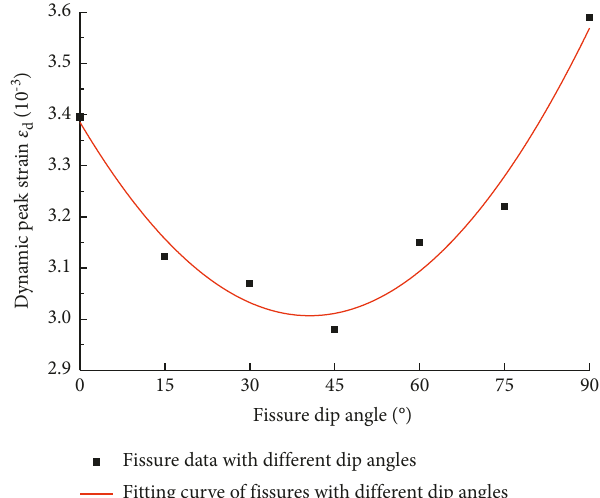
Figure 7: Relationship between the fissure angle and dynamic peak strain.